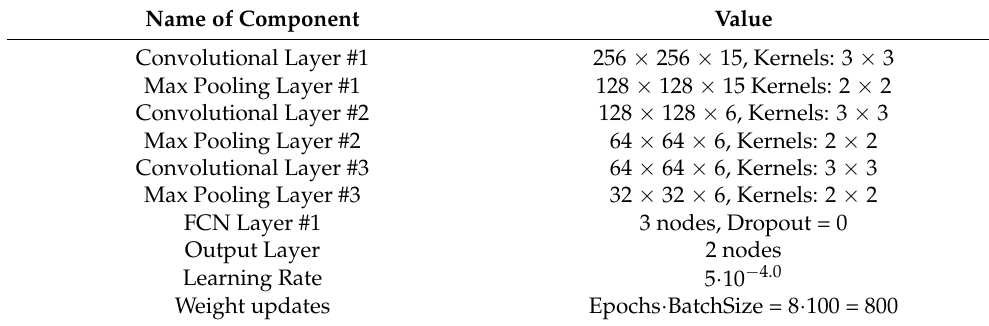
Table 7. Architecture of 1D CNN .